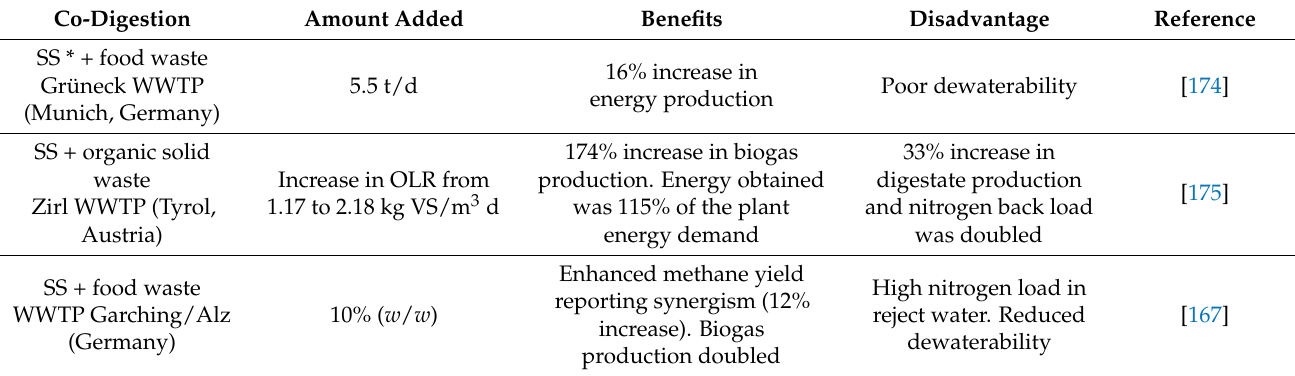
Table 5. Benefits reported by large-scale co-digestion studies found in the